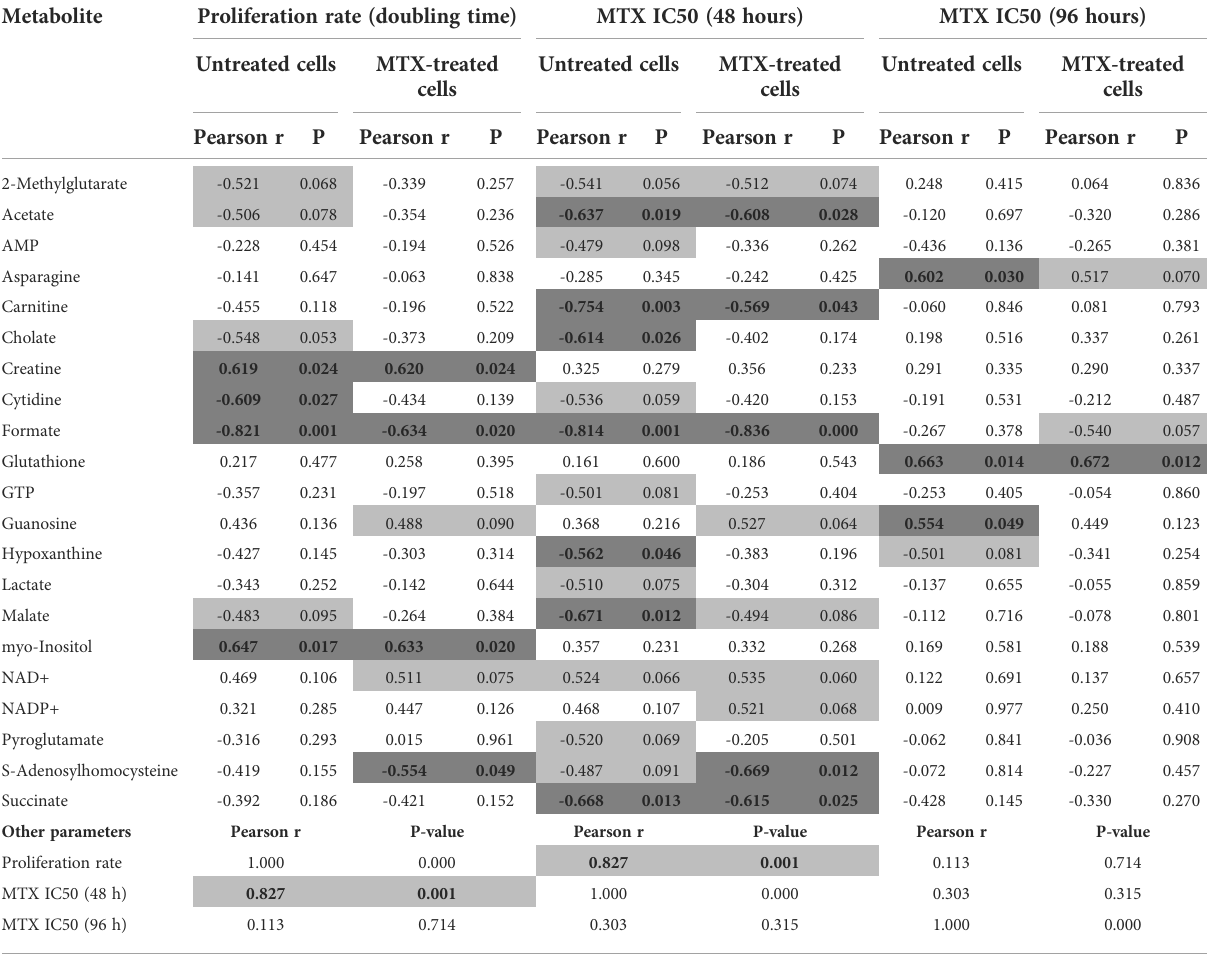
TABLE 1 Correlation between the concentration of selected metabolites and cell proliferation (expressed in terms of doubling time, in days) or MTX resistance (at 48 or 96 hours) in cells either treated or not with MTX.